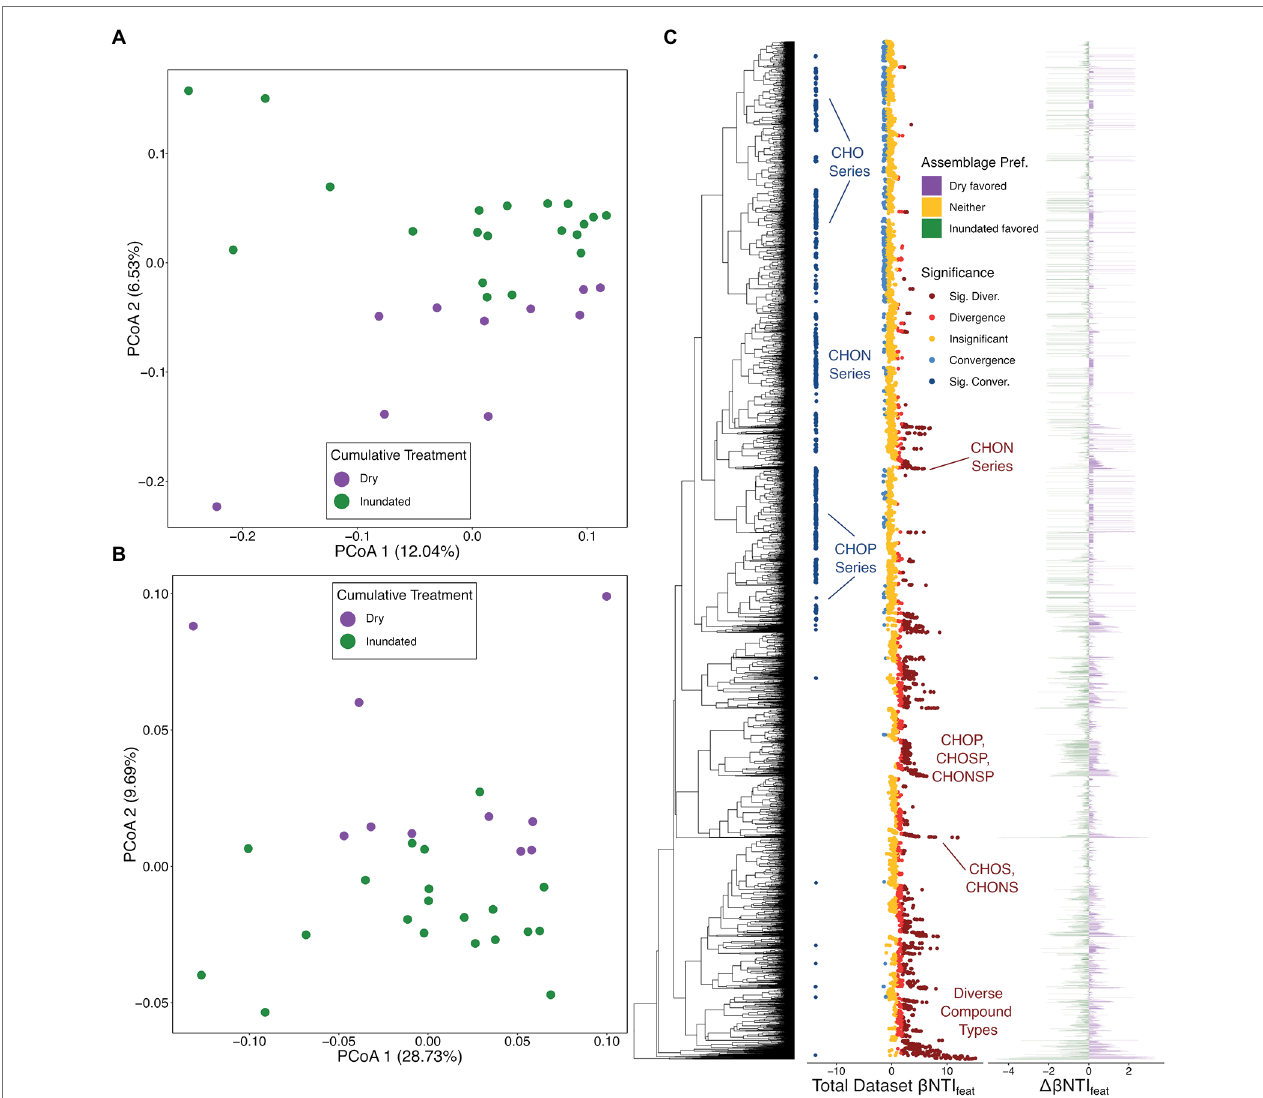
FIGURE 4 | Organic matter (OM) ordinations and overview of OM feature-level β -nearest taxon index ( β NTI feat ) results. (A) Jaccard dissimilarity-based principal coordinate analysis (PCoA) with colors representing treatment type. (B) β -mean nearest taxon distance ( β MNTD)-based PCoA with a legend matching panel (B) . (C) β NTI feat results consisting of three panels: the molecular characteristics dendrogram (MCD), β NTI feat values for the whole dataset with colors indicating contribution to ecological assembly (Direction), and the difference in β NTI feat values across the dry-treatment OM assemblage and inundated-treatment OM assemblage (Assemblage Pref.). Under the Direction legend, “Insignificant” represent | β NTI feat | < 1, “Convergence” or “Divergence” indicate 1 < | β NTI feat | < 2, and “Sig. Conver.” or “Sig. Diver.” represent | β NTI feat | > 2. Under the Assemblage Pref. legend, “Dry favored” indicates that aa given molecular formula had a higher absolute β NTI feat value within dry assemblages, “Inundated favored” indicates that a given molecular formula had a higher absolute β NTI feat value in inundated assemblages, and “Neither” indicates no difference between assemblages. Organic matter groups discussed throughout the manuscript are called out where